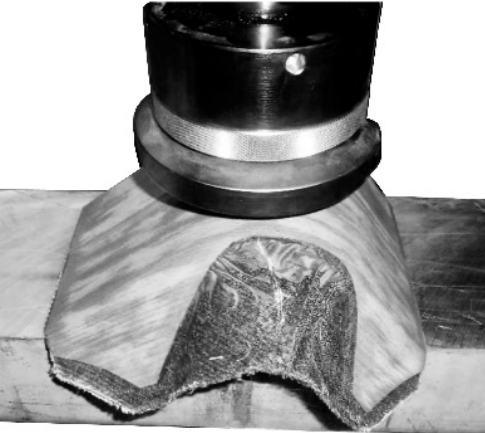
Figure 5. Bending test for 3D molded plywood samples.